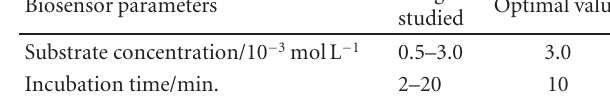
Table 1: Summary of estimated EIS parameters obtained for the carbon nanotube paste electrode and CNTs-AChE biosensor.